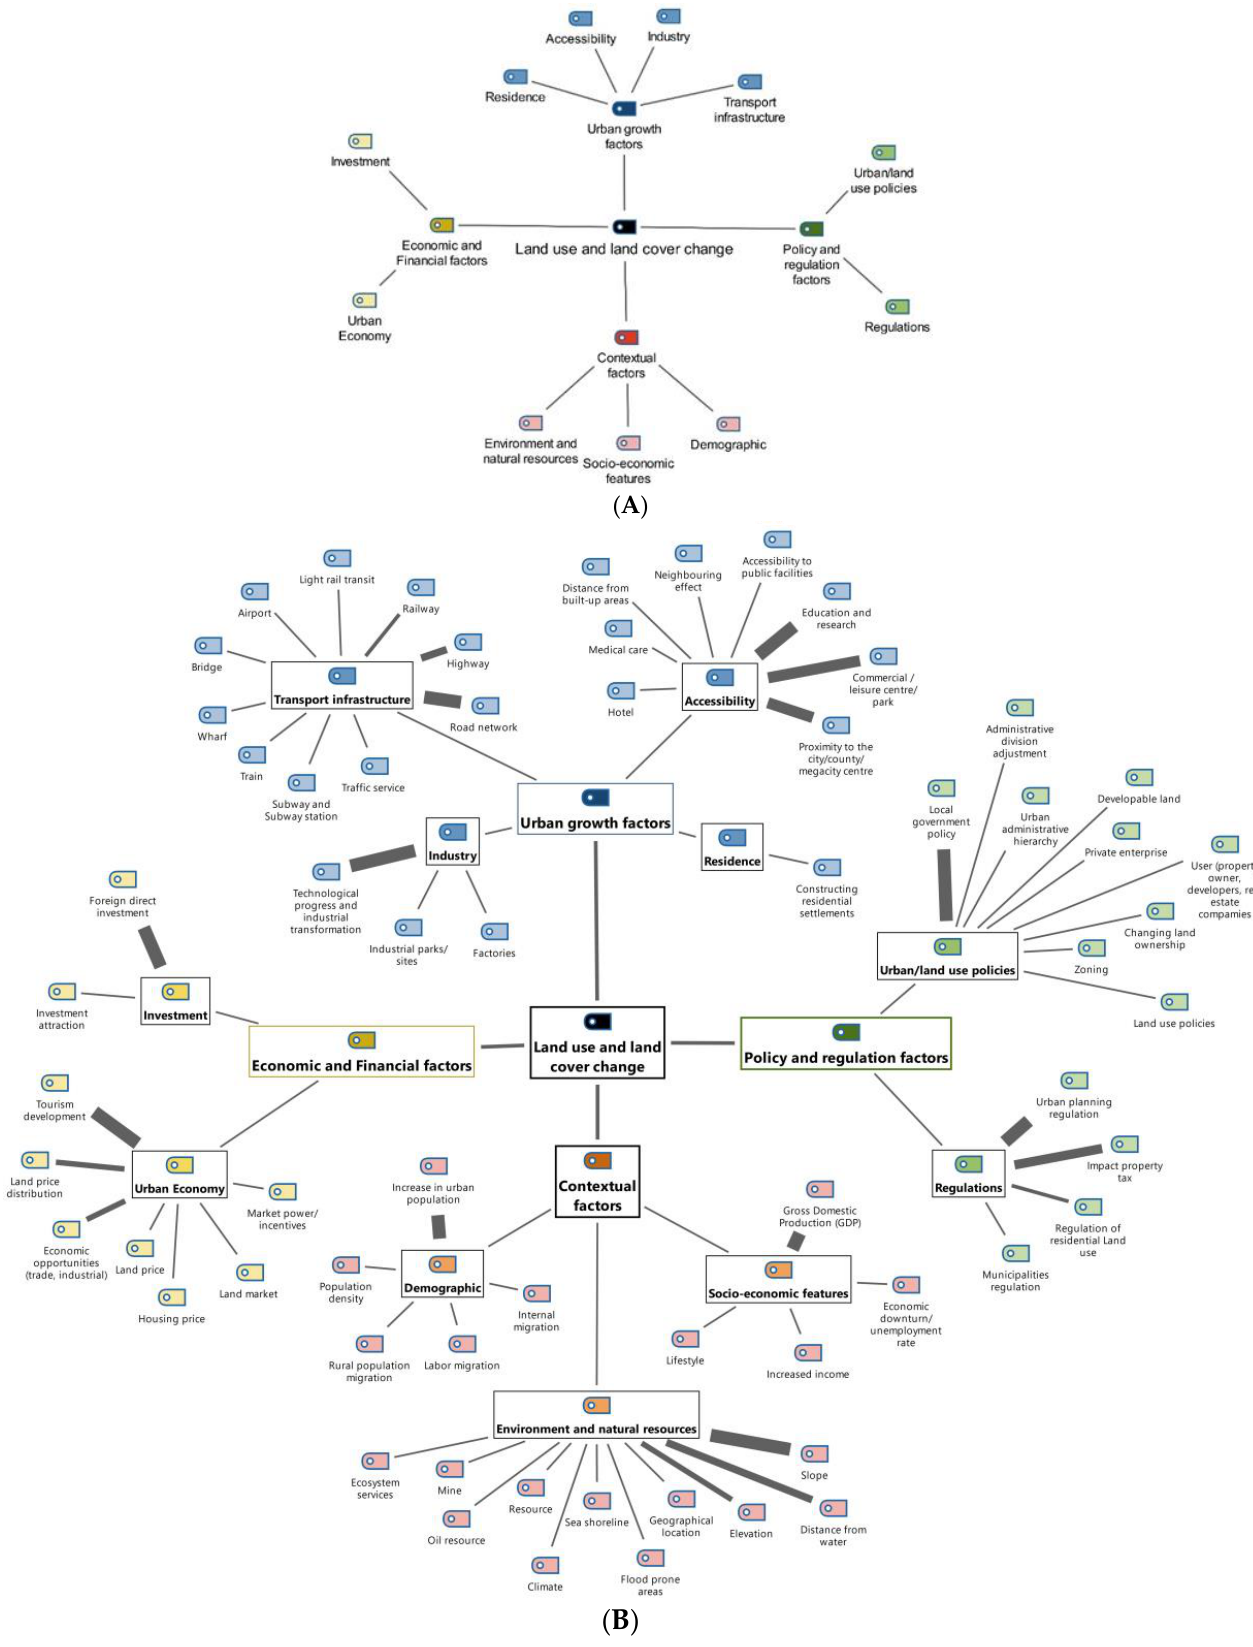
Figure 6. Components of the driving forces system causing LULCC: ( A ) themes and sub-themes (top); ( B ) theme, sub-themes, and factors (codes)